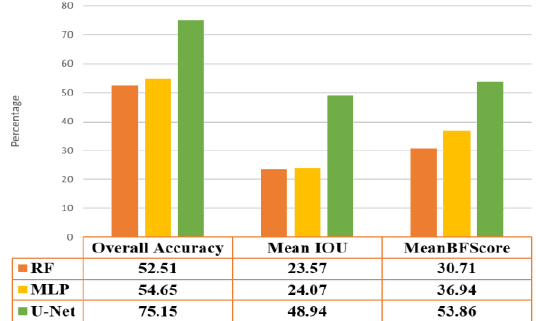
Figure 7 . Comparison of OA, MIOU, and MeanBFScore metrics for three RF, MLP, and U-Net models.